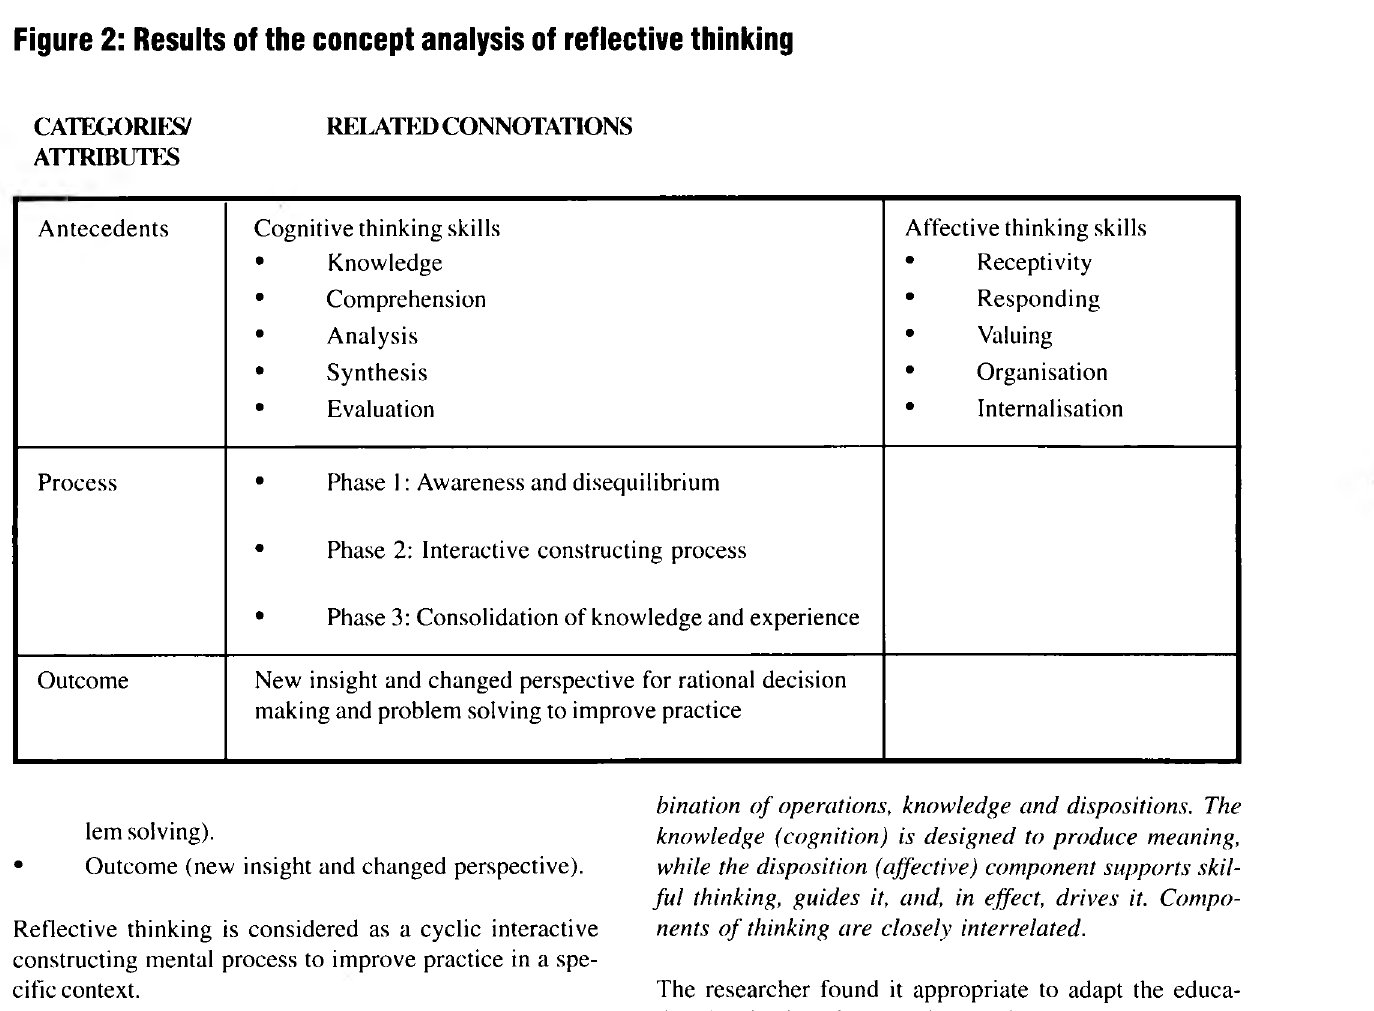
Figure 2: Results of the concept analysis of reflective thinking